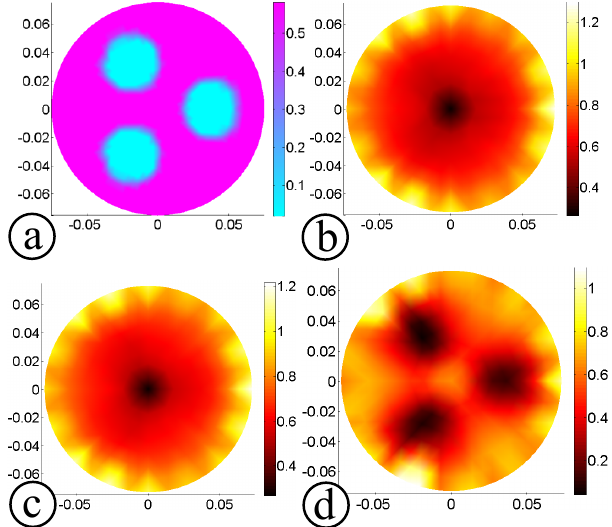
Fig.1 9: Conductivity reconstruction of the phantom with tripple inhomogeneity (D = 40 mm, L = 50.0 mm) near electrode No.-1, between electrode No.-6-7 and between electrode No.-11-12 ( λ = 0.0011): (a) original object, (b) image with STR, (c) image with LMR, (d) image with BMMR.